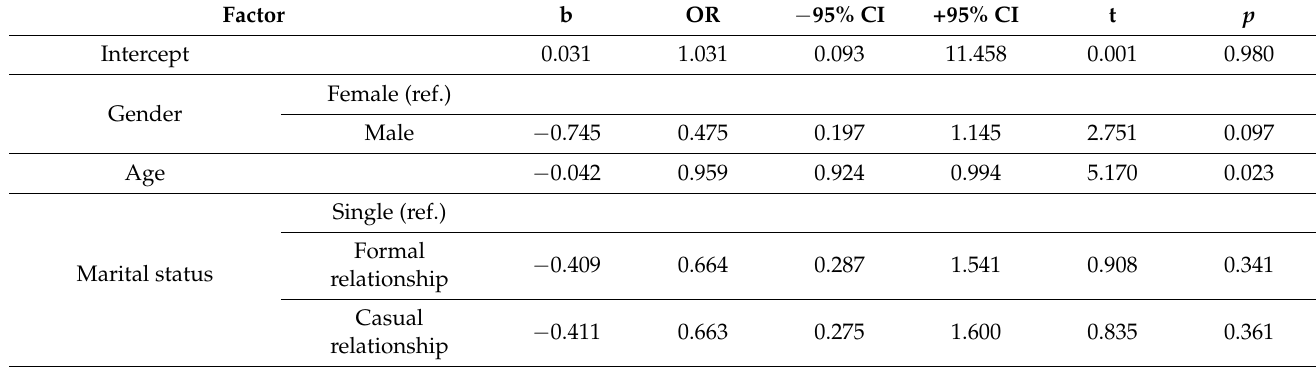
Table 1. Influence of sociodemographic variables on the occurrence of insomnia according to the